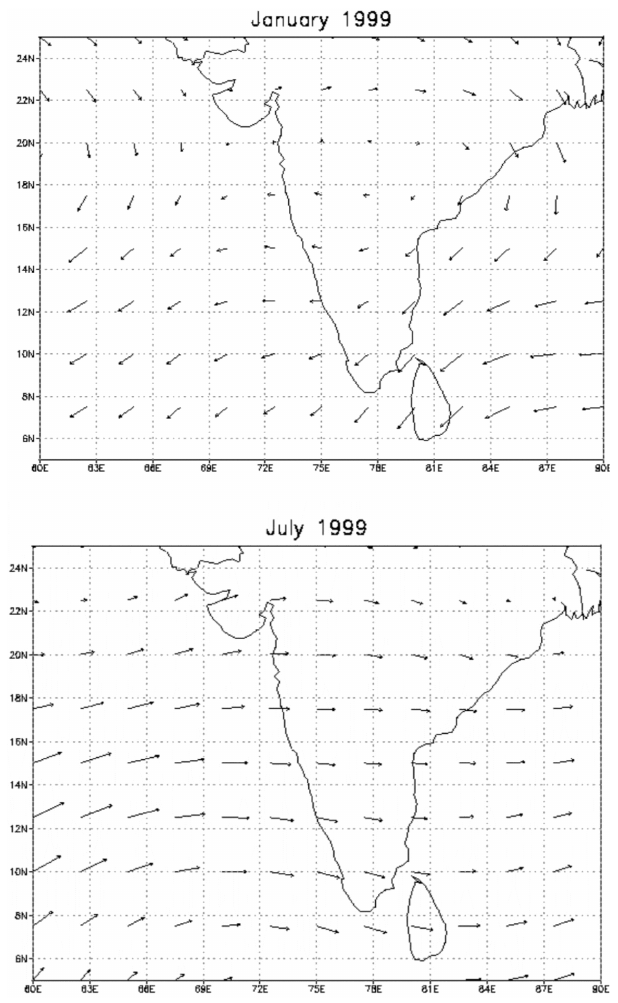
Fig. 1. Prevailing mean wind pattern at 850mb for the month of January 1999 and July